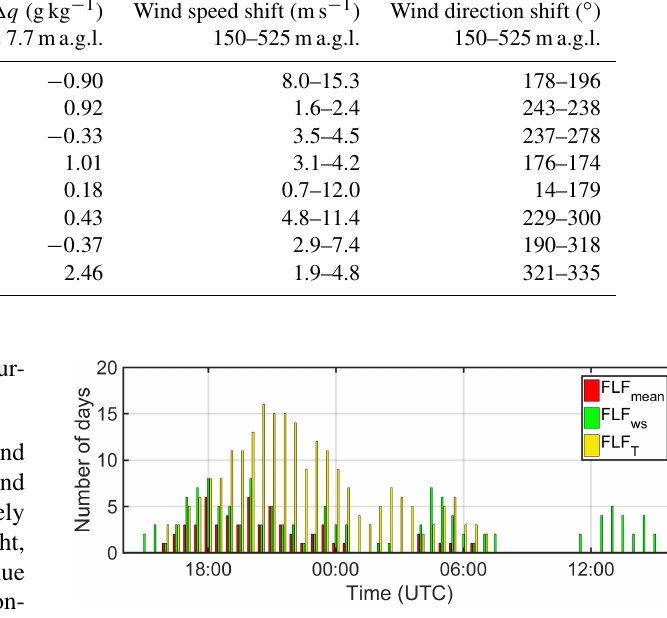
Figure 5. Temporal occurrence of fuzzy logic functions equal to 1 for temperature (FLF T ), wind speed (FLF ws ), and mean fuzzy logic function (FLF mean ) for the period between 1 and 30 July.